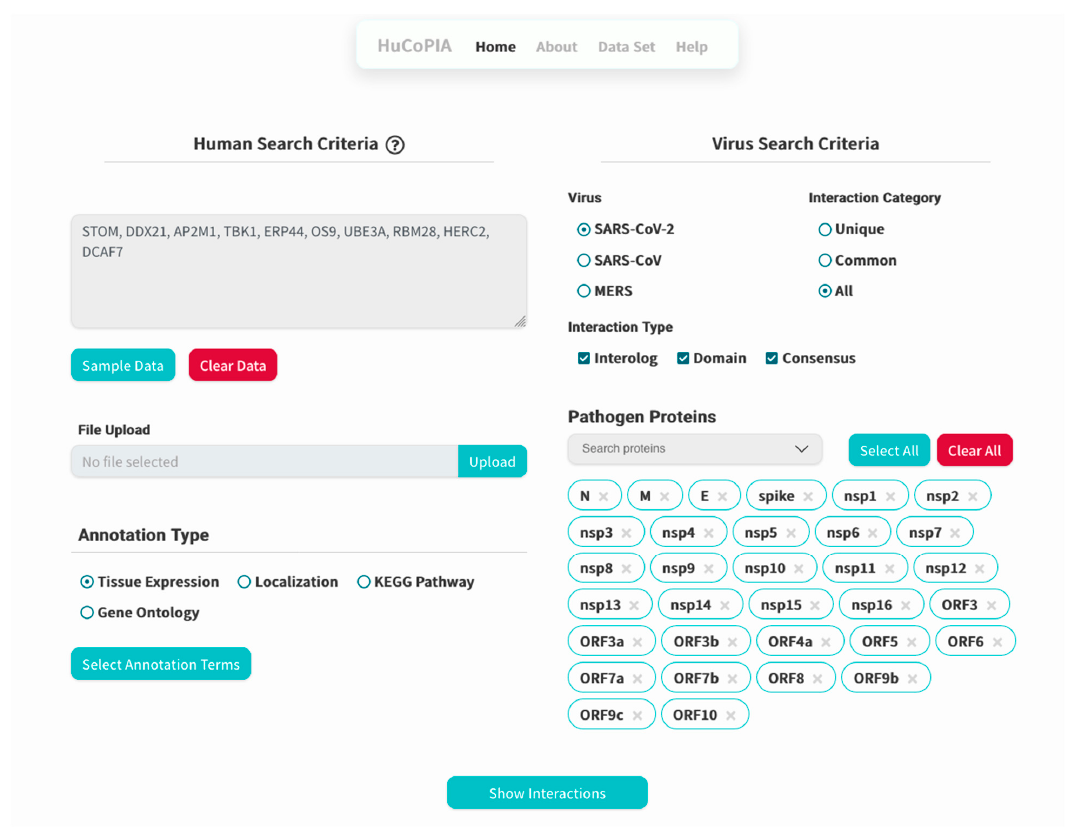
Figure 2. Home page of HuCoPIA. Figure 2. A snapshot of the results page of HuCoPIA.